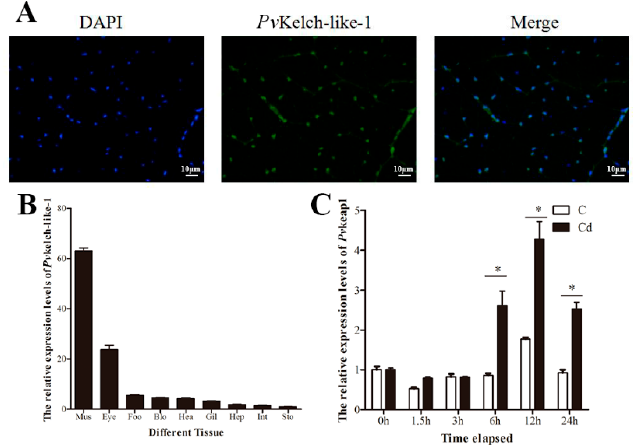
Figure 2. Subcellular localization and expression pattern of PvKelch-like-1. ( A ) Immunofluorescence analysis. Blue fluorescence is DAPI-stained nucleus of muscle cells, green fluorescence is the distribution of PvKelch-like-1 protein in cells. Pictures were taken at a magnification of 400 × fluorescence microscope; ( B ) the differential mRNA expression of PvKelch-like-1 in muscle (Mus), eyetalk (Eye), foot (Foo), hemolymph (Hem), hepatopancreas (Hep), gill (Gil), stomach (Sto), heart (Hea), intestine (Int). Vertical bars are presented as mean ± SD ( n = 3); ( C ) expression of PvKelch-like-1 in the hepatopancreas of shrimp after cadmium challenge. Vertical bars represent the mean ± SD ( n = 3). Di ff erent letters indicate statistically significant di ff erences ( p < 0.05) relative to normal shrimp (0 h). Asterisks indicate statistically significant di ff erences ( p < 0.05) between the two treatment groups.